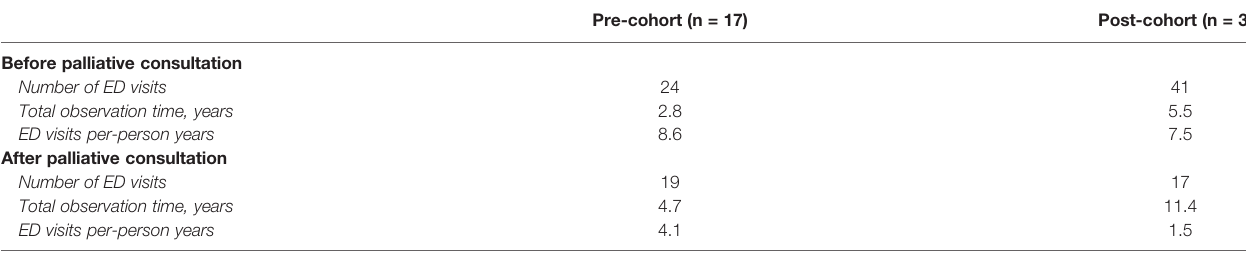
TABLE 3 | Emergency department (ED) visits comparing pre- and post-cohort before and after palliative care